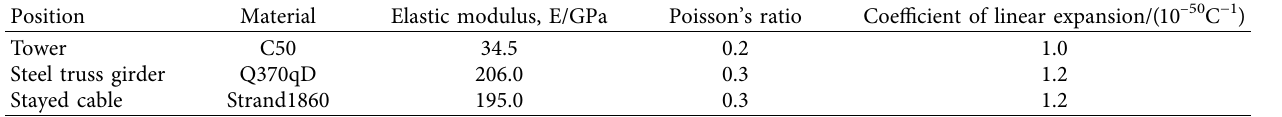
Table 1: Physical properties of main materials.